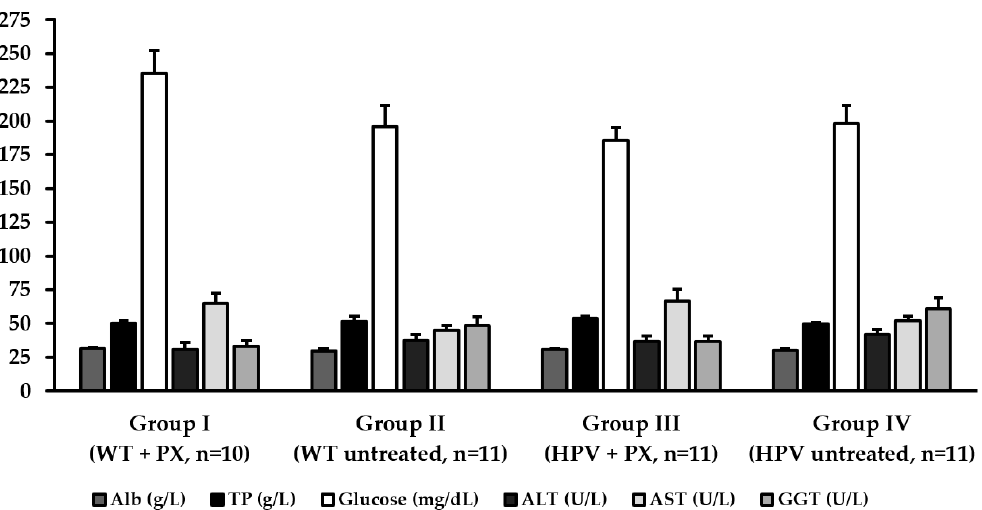
Figure 7. Biochemical parameters (mean ± standard deviation). Alb—albumin; ALT—alanine aminotransferase; AST—aspartate aminotransferase; GGT—gamma glutamyl transferase; HPV –human papillomavirus; PX—parecoxib; TP—total proteins; WT—wild-type.